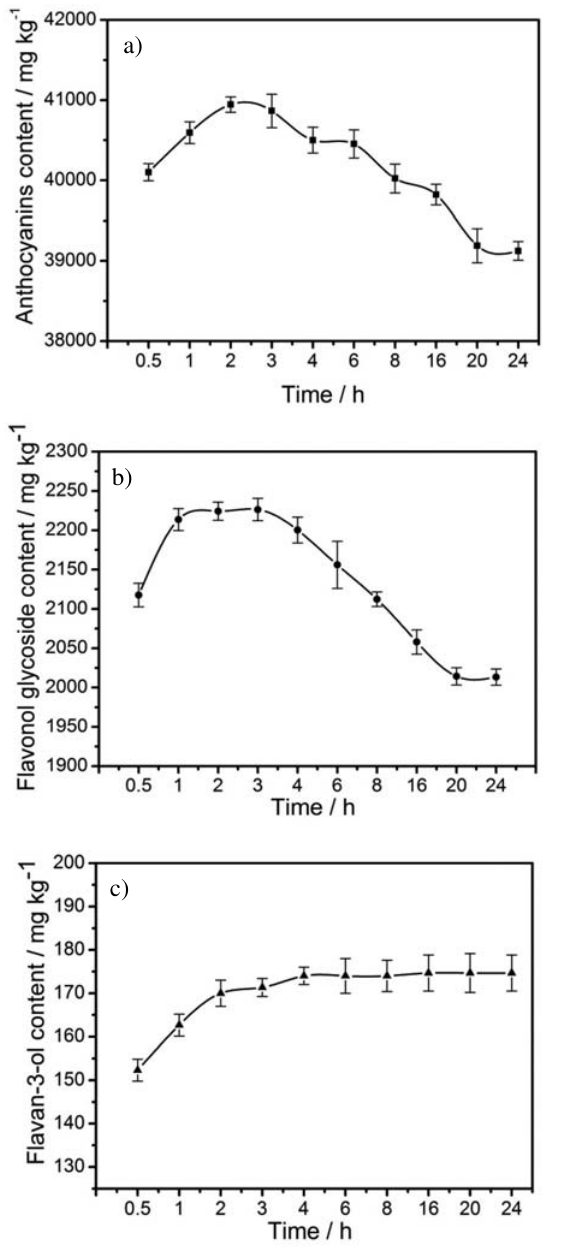
Fig. 2. Effect of extraction time on a) anthocyanin contents; b) fla- vonol glycoside contents and c) flavan-3-ol contents from